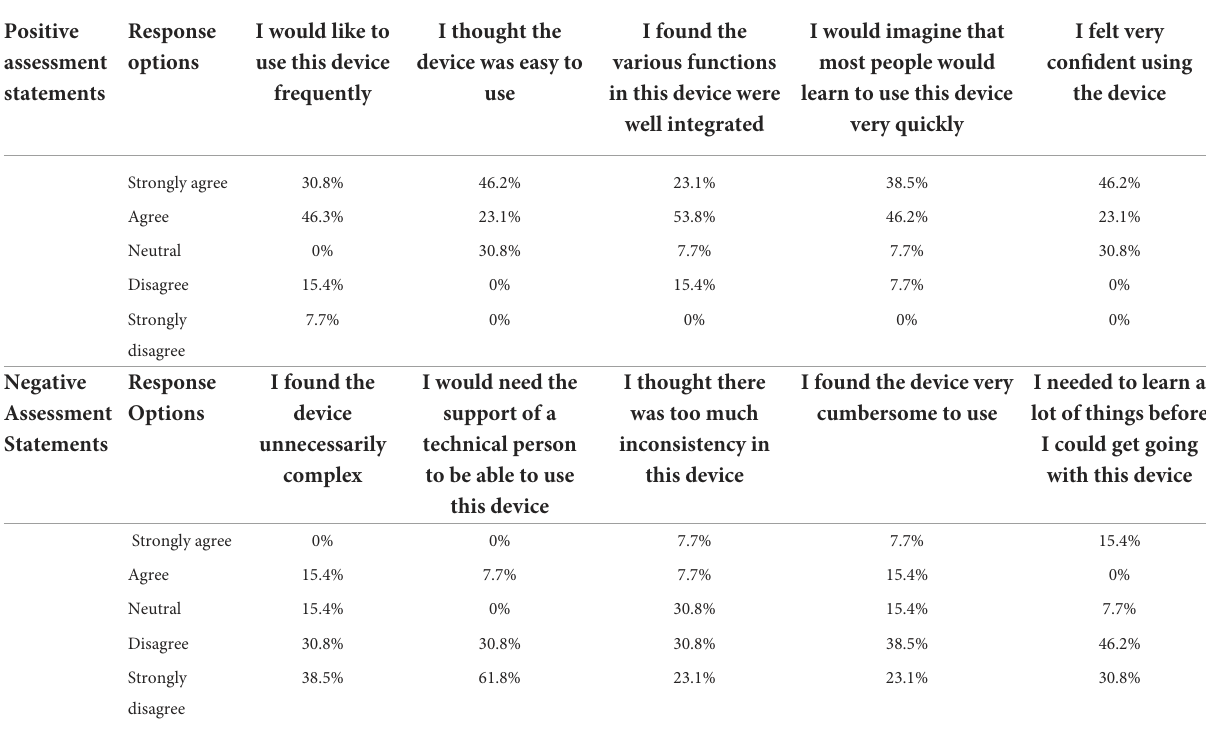
TABLE 1 Results from the human factors trial usability